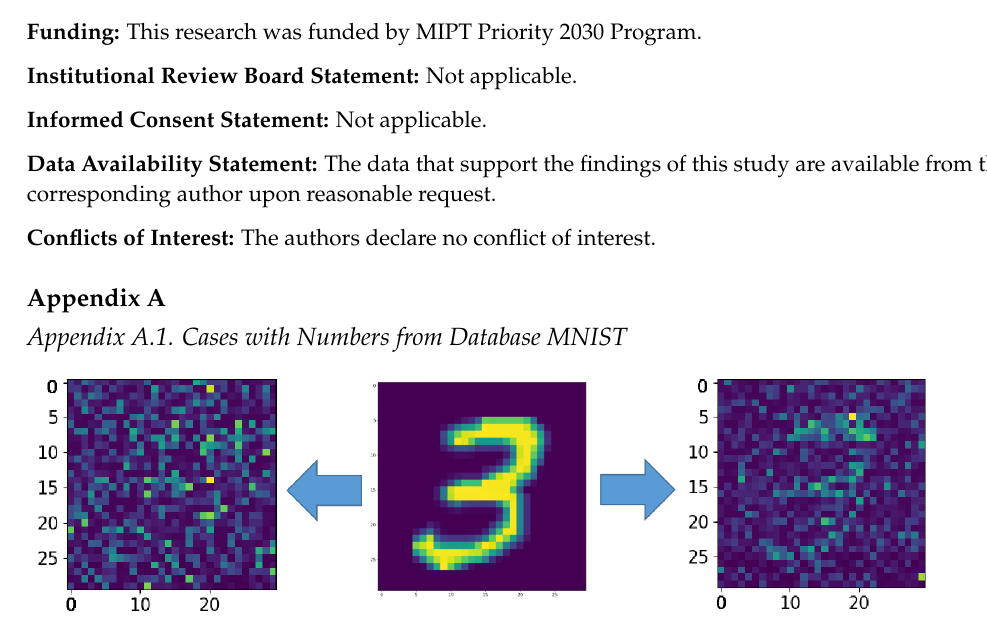
Figure A1. The middle picture is the supplied pattern (3 from handwritten database MNIST (MNIST dataset is made available under the terms of the Creative Commons Attribution-Share Alike 3.0 license)) [39], on the left, encoded by the spiking neural network without astrocyte modulation and noise amplitude A noise = 6, and on the right, with astrocyte modulation and noise amplitude A noise = 6.